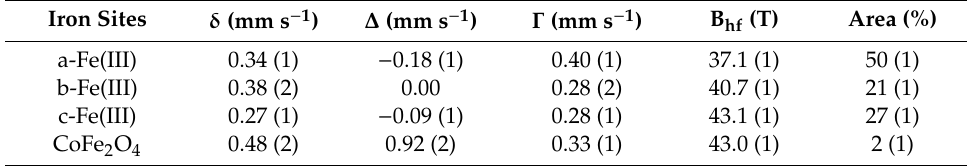
1 δ —Isomer shift, referred to α -iron at 295 K; ∆ —quadrupole splitting, Γ —linewidth, Bhf—hyperfine